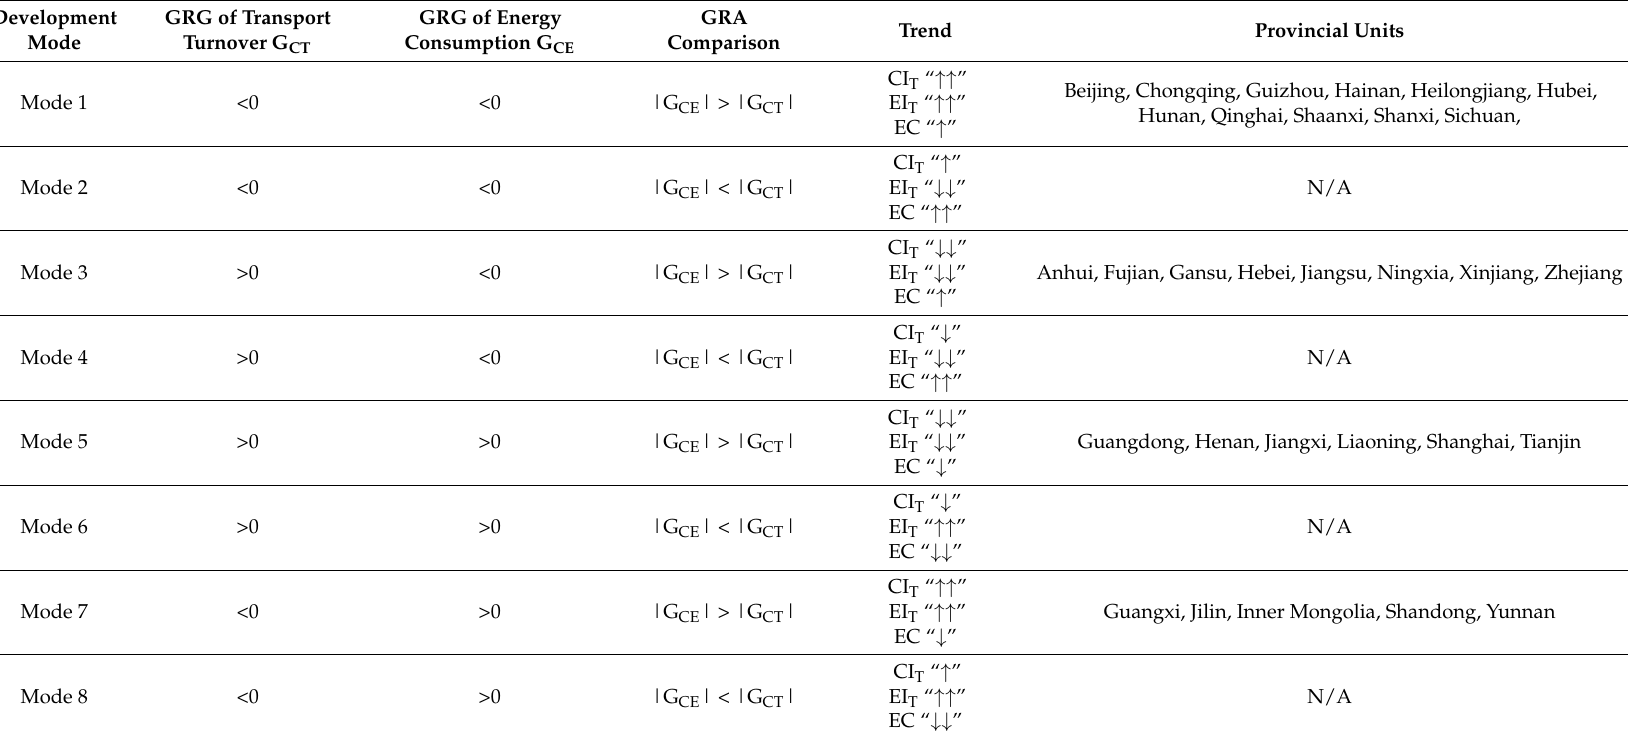
Table 2. The Development Modes of China’s Provincial Transport Sector from 1994 to